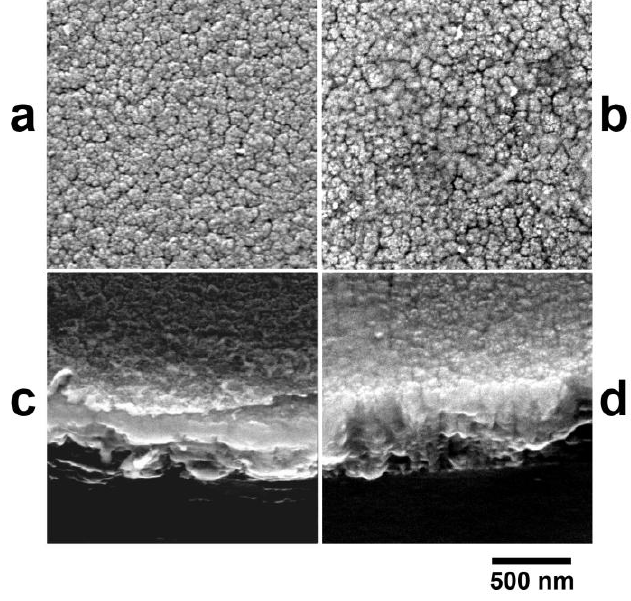
Figure 2. Scanning electron microscope micrographs showing top-view and cross sections (taken at 30° angle of incidence) of the post-annealed films sputtered at ( a , c ) P and ( b , d ) P = 1.3 O 2